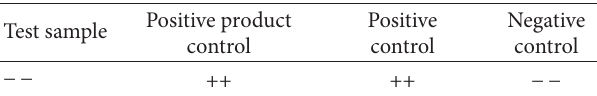
Table 4: Bacterial endotoxin analysis of ultrapure paraffin oil aqueous extracts. Test